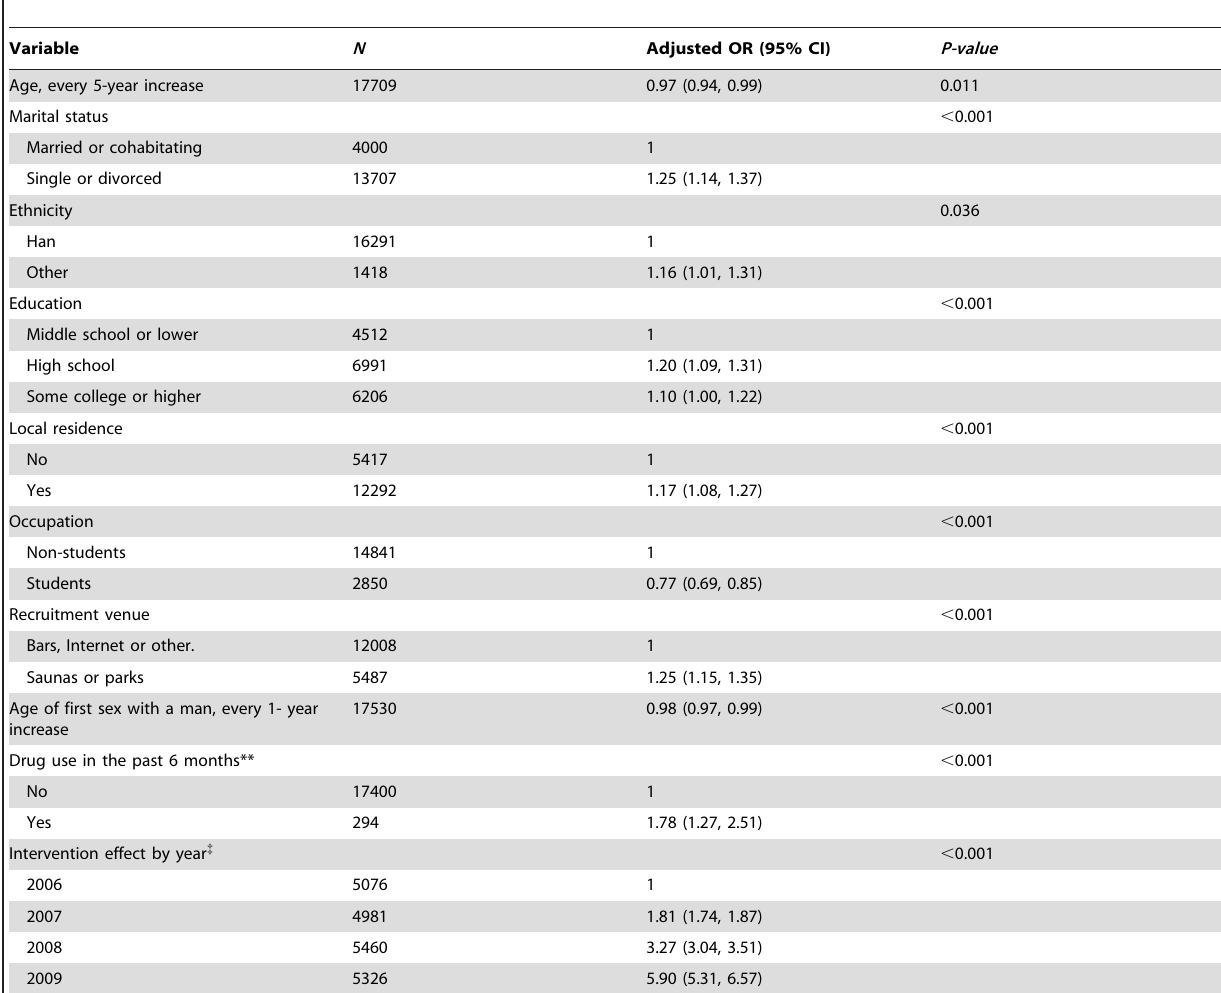
Table 3. Logistic regression of receipt of any self-reported interventions { among MSM in 16 Chinese cities (surveys from all 4 years, 2006–2009).